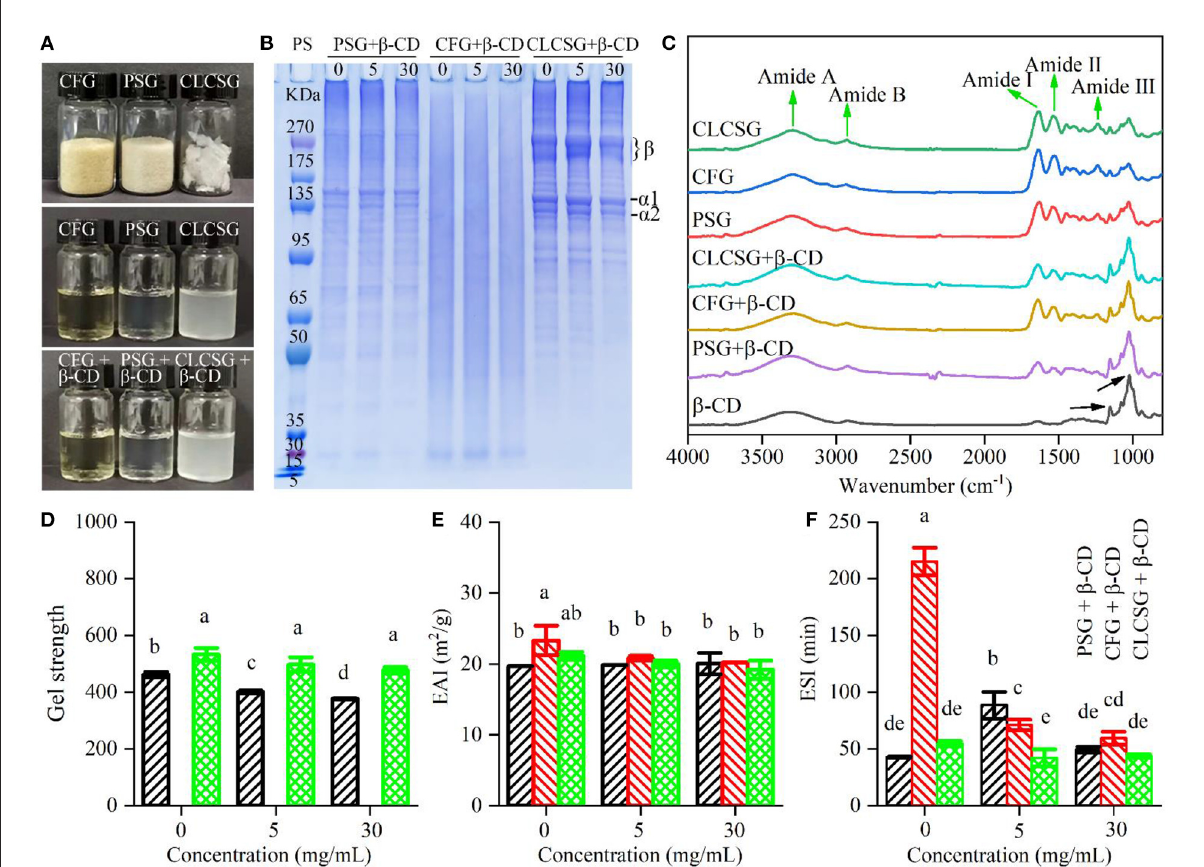
FIGURE1 Structural and functional properties of gelatins (PSG, porcine skin gelatin; CFG, cold-water fish skin gelatin; and CLCSG, Chinese longsnout catfish skin gelatin) with β -cyclodextrin ( β -CD). (A) Digital camera images of solid gelatins, gelatin solutions (66.70 mg/mL), and gelatin solutions (66.70 mg/mL) with β -CD (5 mg/mL). (B) SDS-PAGE results. The labels β , α 1, and α 2 indicates the bands those correspond to β chain, β chain, α 1 chain, and α 2 chain, respectively, of collagen. (C) ATR-FTIR spectra of freeze-dried gelatin with β -CD. (D–F) Gel strength values of gelatins with β -CD at different β -CD concentrations (0, 5, and 30,